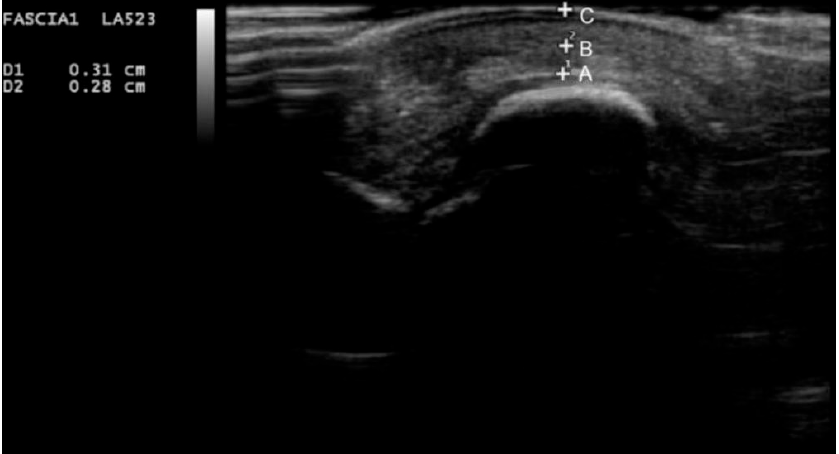
Figure 1. Ultrasound image of the sub-metatarsal skin and fat pad thickness under the medial sesamoid. Point A to point B, representing the thickness of the sub-metatarsal fat pad; point B to point C, representing the thickness of the sub-metatarsal skin.